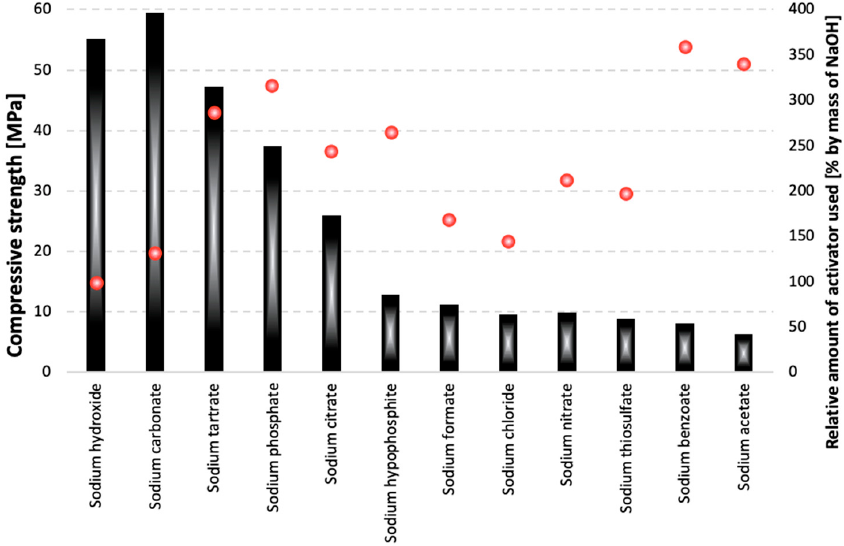
Figure 3. The relation between the compressive strength of pastes after 180 days of curing and the amount of activator used in their preparation. Red dots—relative amount of activator.